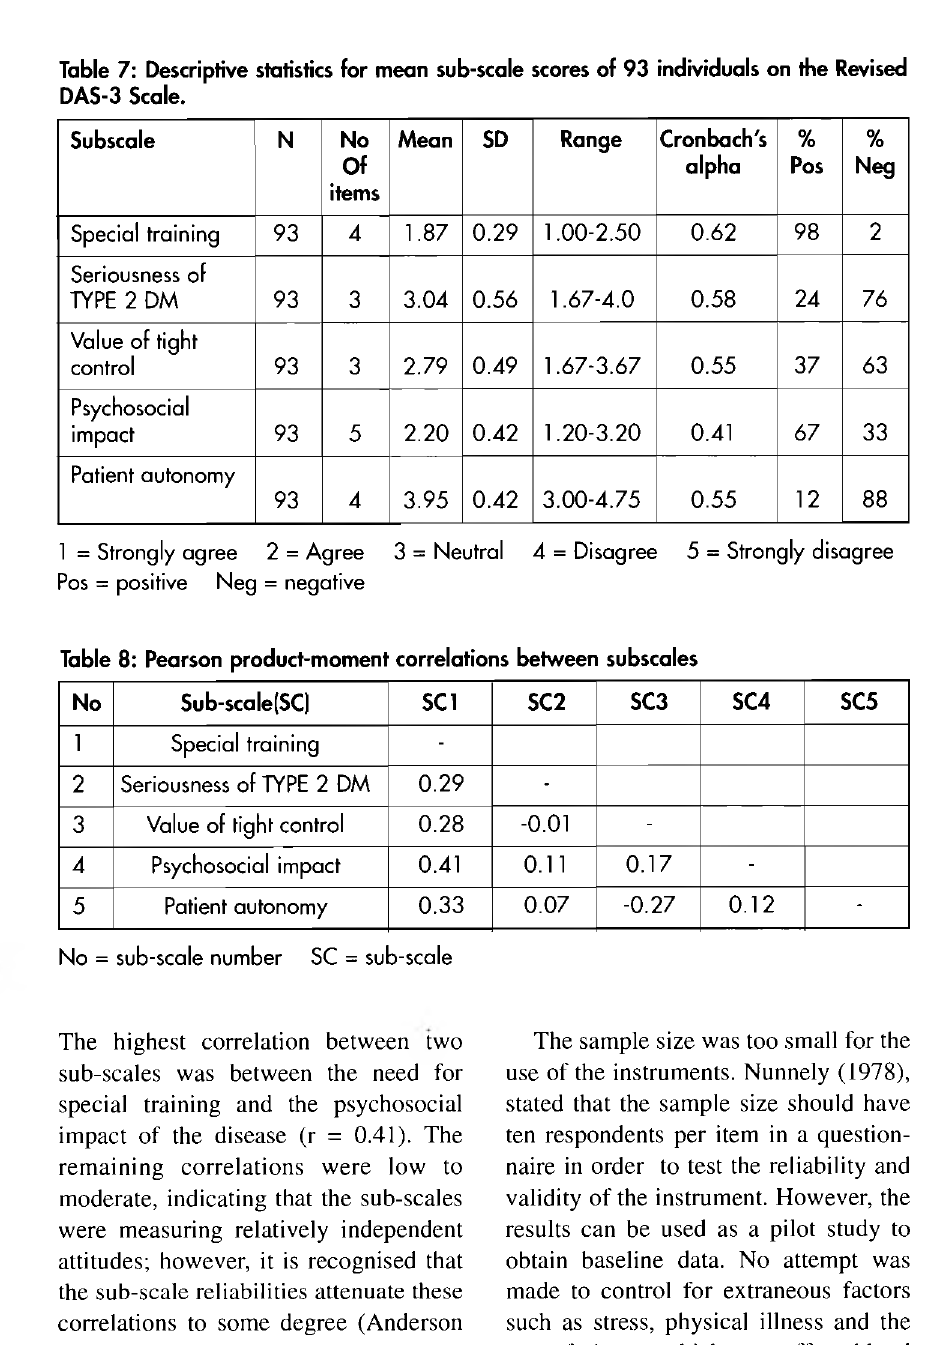
Table 7: Descriptive statistics for mean sub-scale scores of 93 individuals on the Revised DAS-3 Scale.